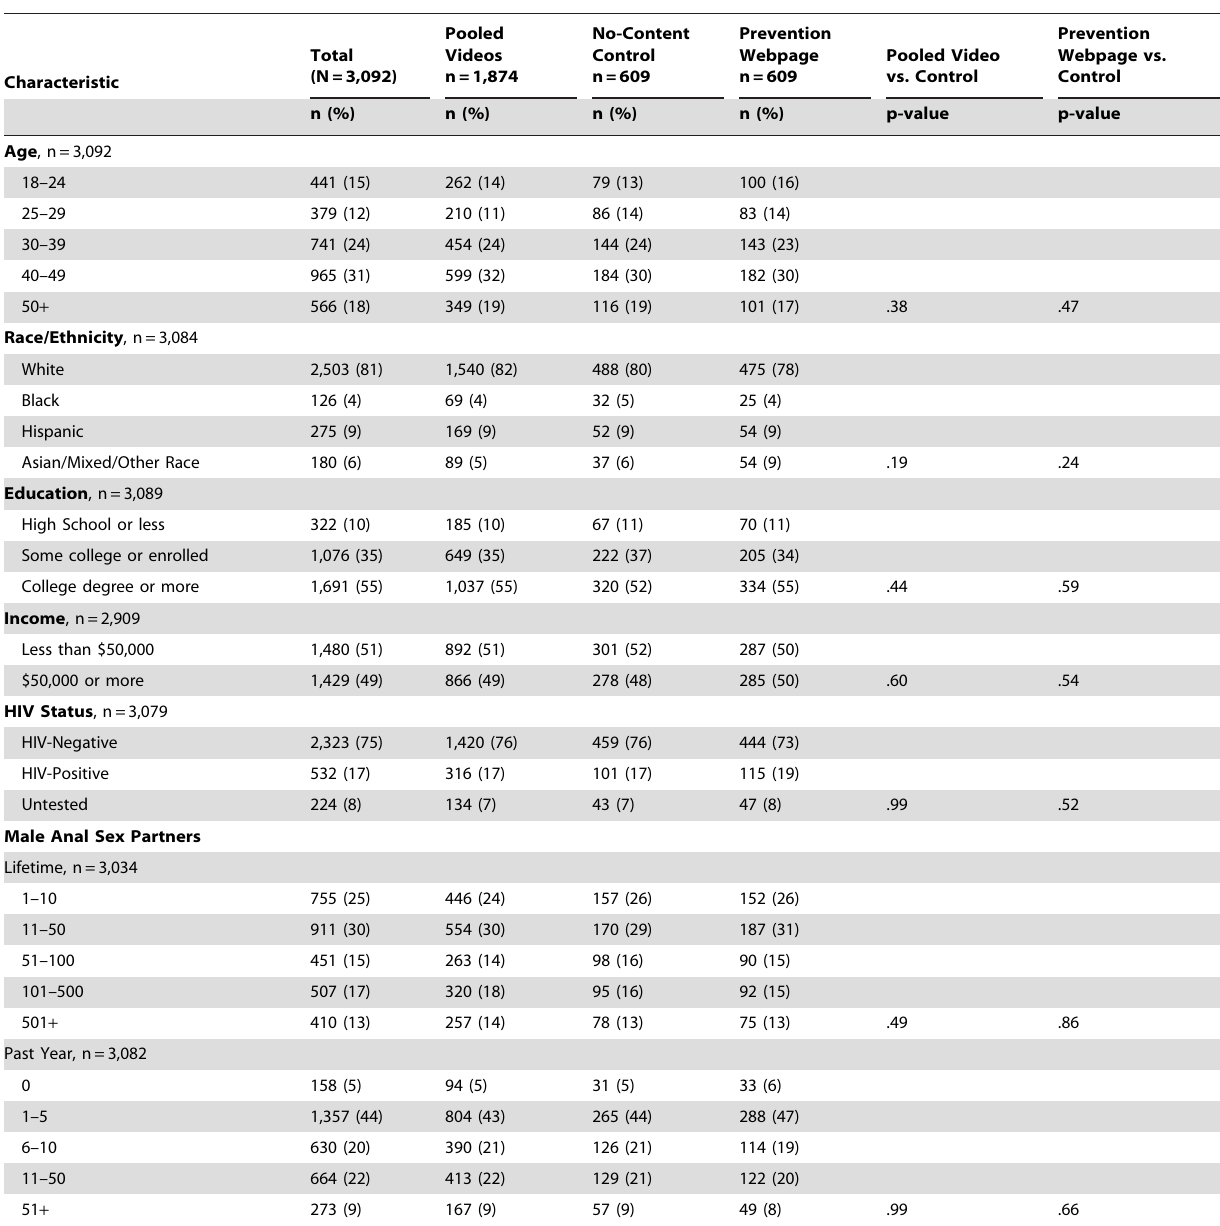
Table 1. Baseline Demographic and Behavioral Characteristics by Randomization